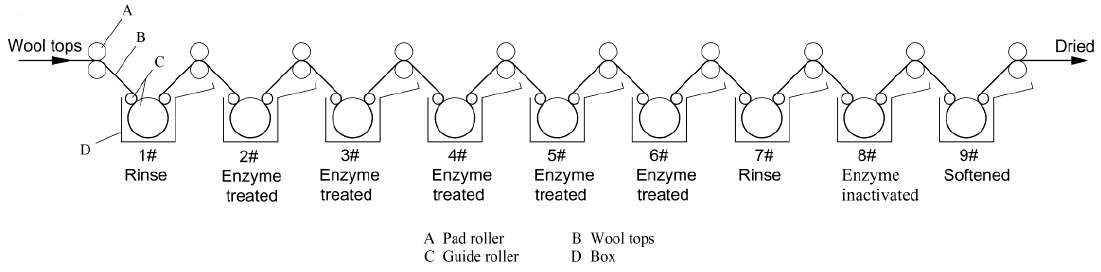
Figure 1. Schematic of multiple padding enzyme treatment in the plant.